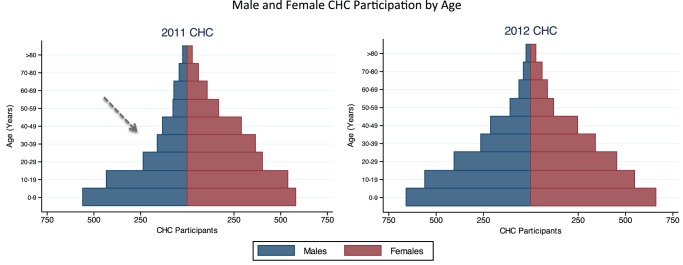
Change in male and female participation from a 2011 to a 2012 community health campaign (CHC) in Kakyerere parish, a rural Ugandan community.Shown are the age and sex distribution of CHC participants, including non-residents of the community, by year. The dashed arrow indicates the low proportion of adult male participants in the 2011 CHC.